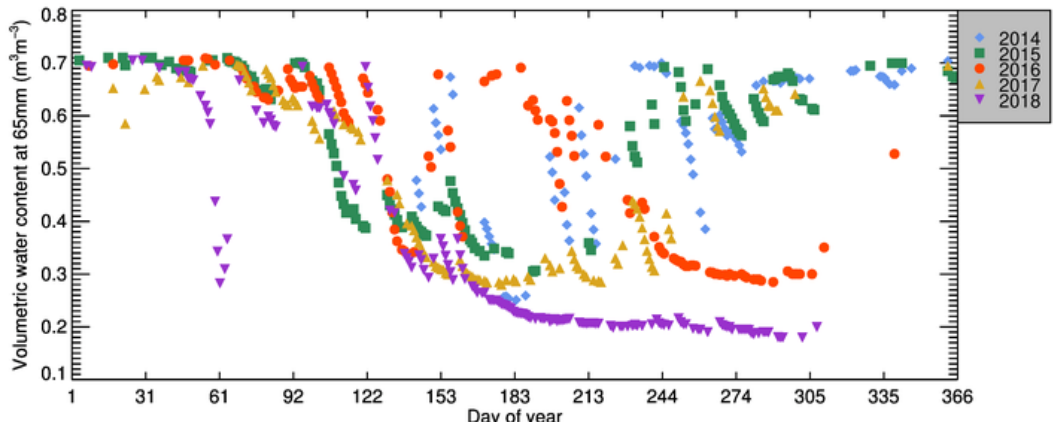
Figure 10. The progression of daily volumetric water content at 65 mm (0–130 mm averaged) from June 2014 to October 2018.